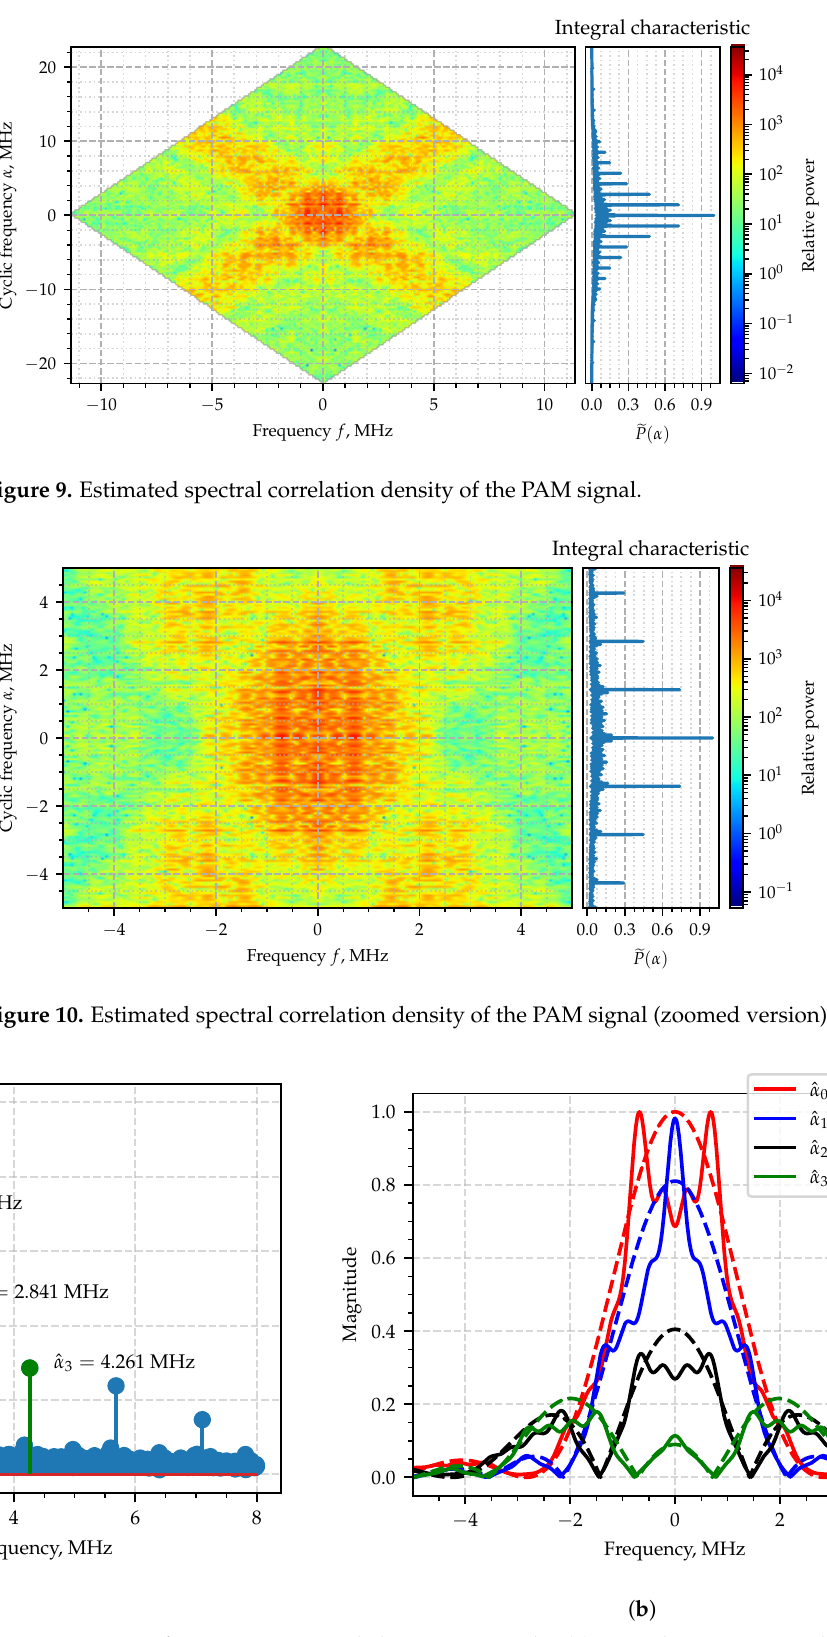
Figure 11. Area of interest in integral characteristics plot ( a ); SCF slice at estimated characteristic cyclic frequency ( b ): the theoretical curves are dashed lines, the estimated ones are